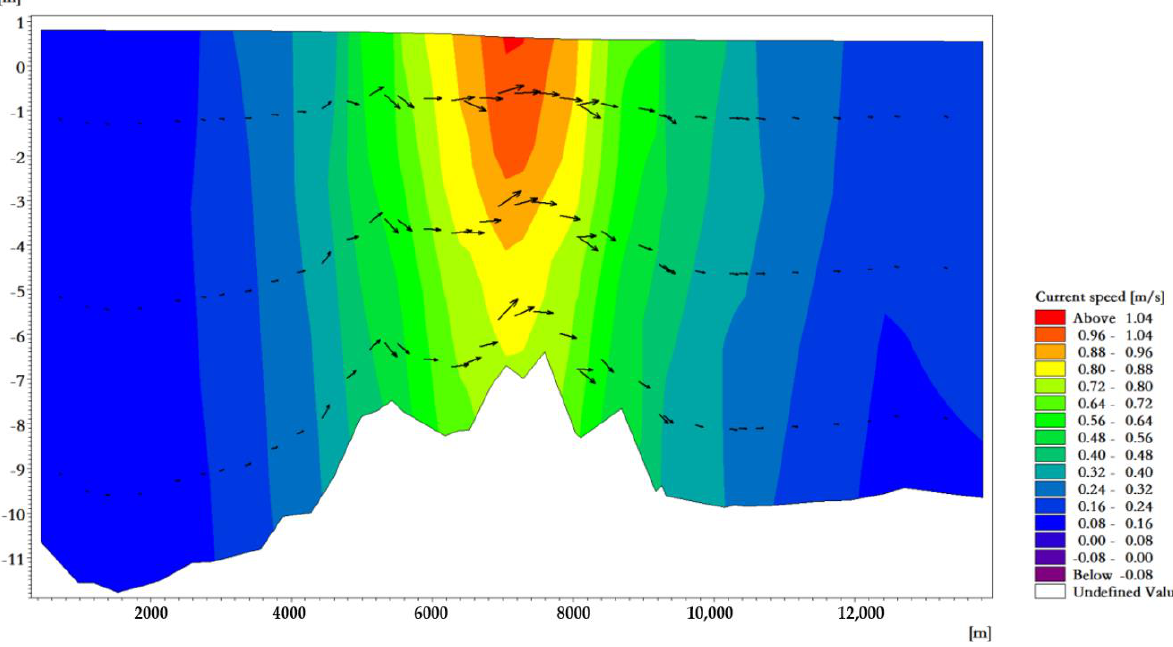
Figure 10. Flow field vertical distribution near the tidal inlet at the moment when the velocity of the ebb tide reaches its maximum.